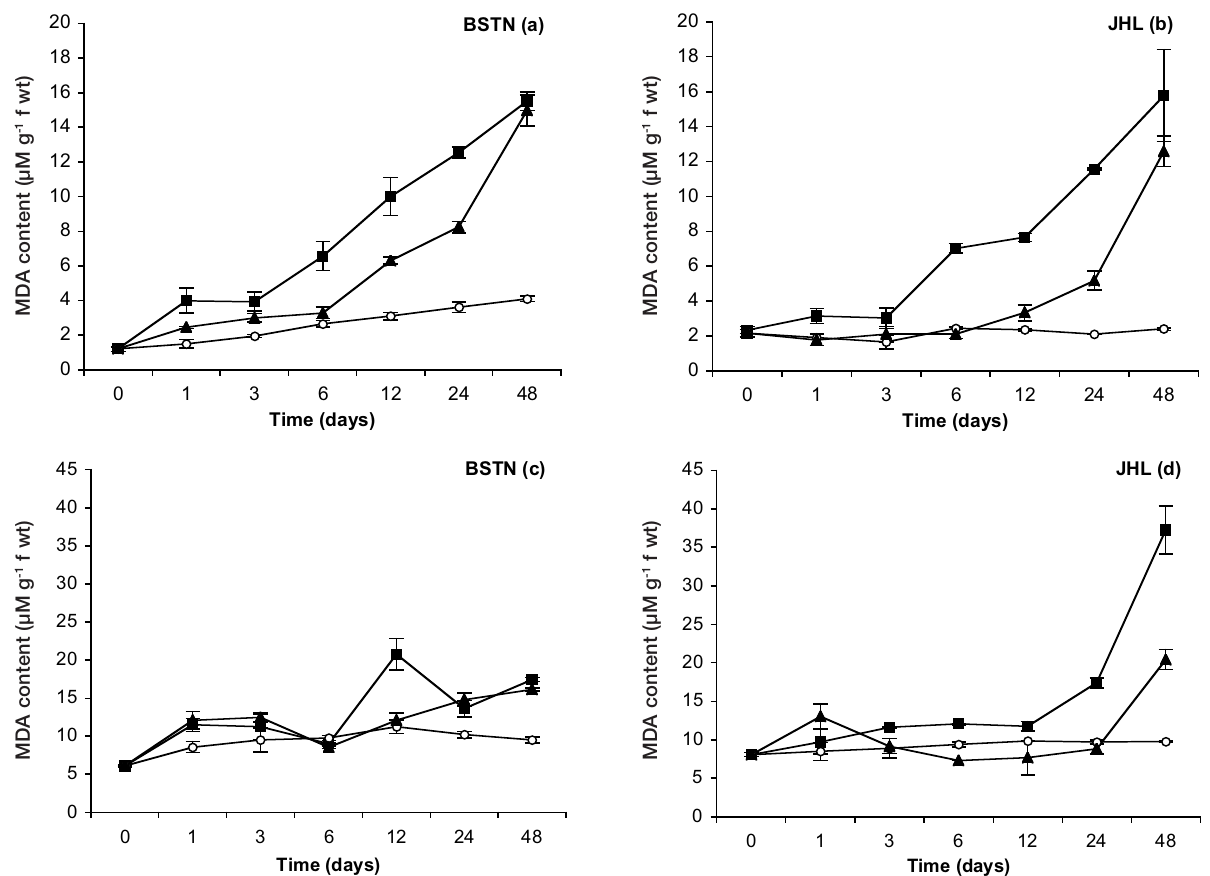
Fig 3. Changes in MDA content in date palm seedling roots (a, b) and leaves (c, d) of cultivars BSTN and JHL after inoculation with Fusarium oxysporum f. sp. albedinis ( Foa ) ( ▲ ); treatment with jasmonic acid ( ■ ); distilled water control ( O